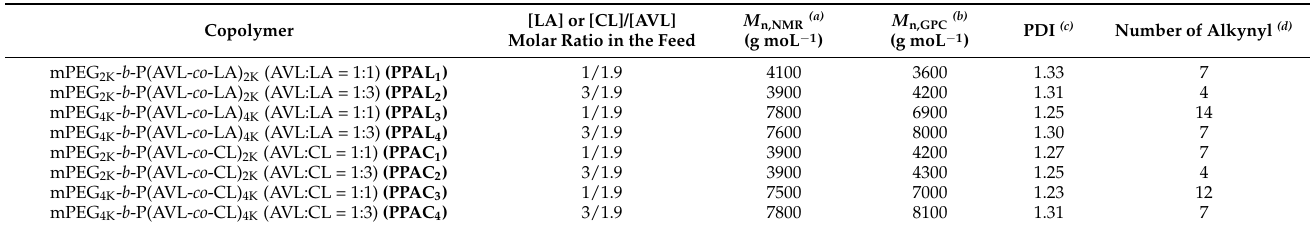
Table 1. Molecular weight and chemical composition of PPAL and PPAC copolymers via ROP. Copolymer [LA] or [CL]/[AVL] Molar Ratio in the Feed M n,NMR